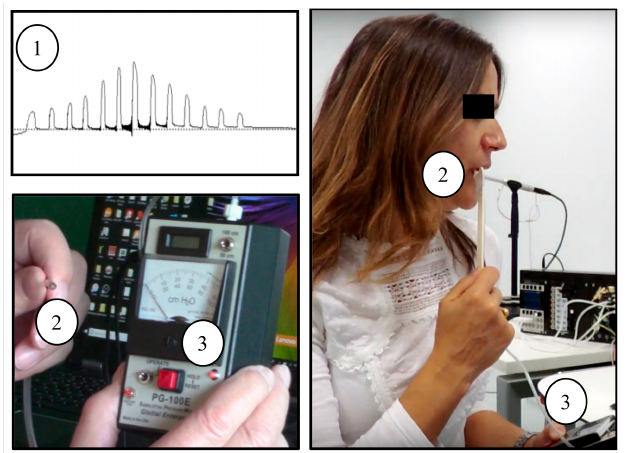
Figure 4. (1) Subglottal pressures for individual notes of an arpeggio, recorded by a PG-100E unit (Glottal Enterprises, USA) and displayed by the software Sopran. (2) Plastic tube placed in the corner